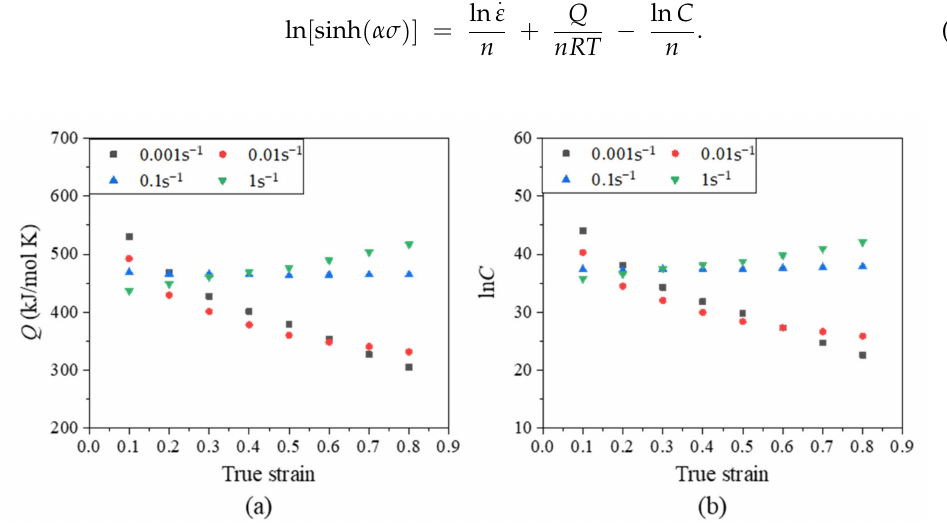
Figure 4. Calculation of the value of ( a ) n by plotting ln[sinh( ασ )] vs. ln ln[sinh( ασ )] vs. 1000/ T . All values correspond to strain 0.8.